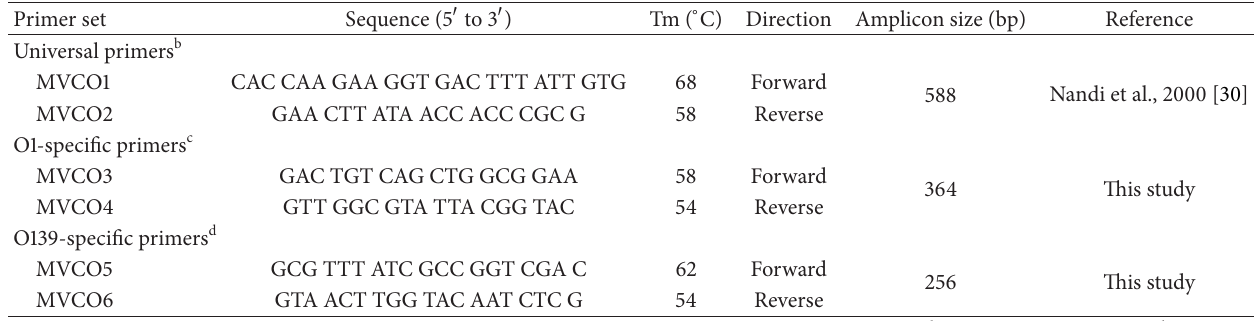
Table 1: Primer sequences a used in touchdown-multiplex